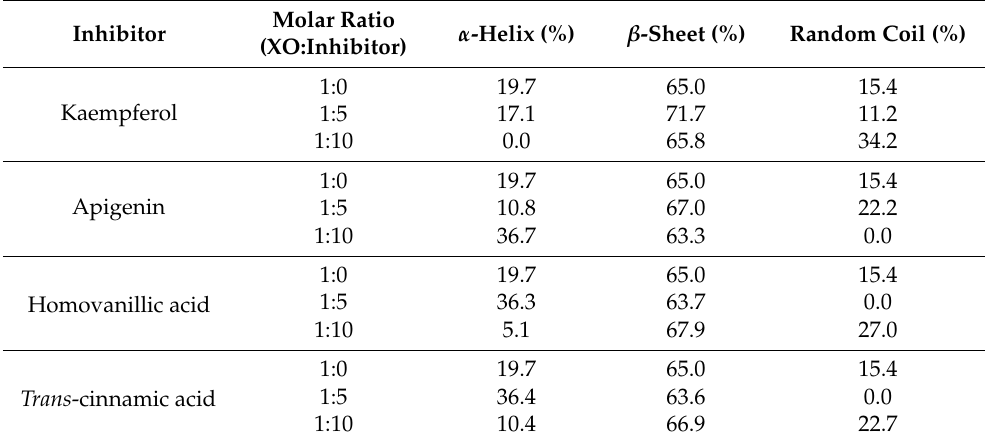
Table 3. The contents of secondary structures of free XO and inhibitor-XO systems (CD spectra) at pH 7.5.